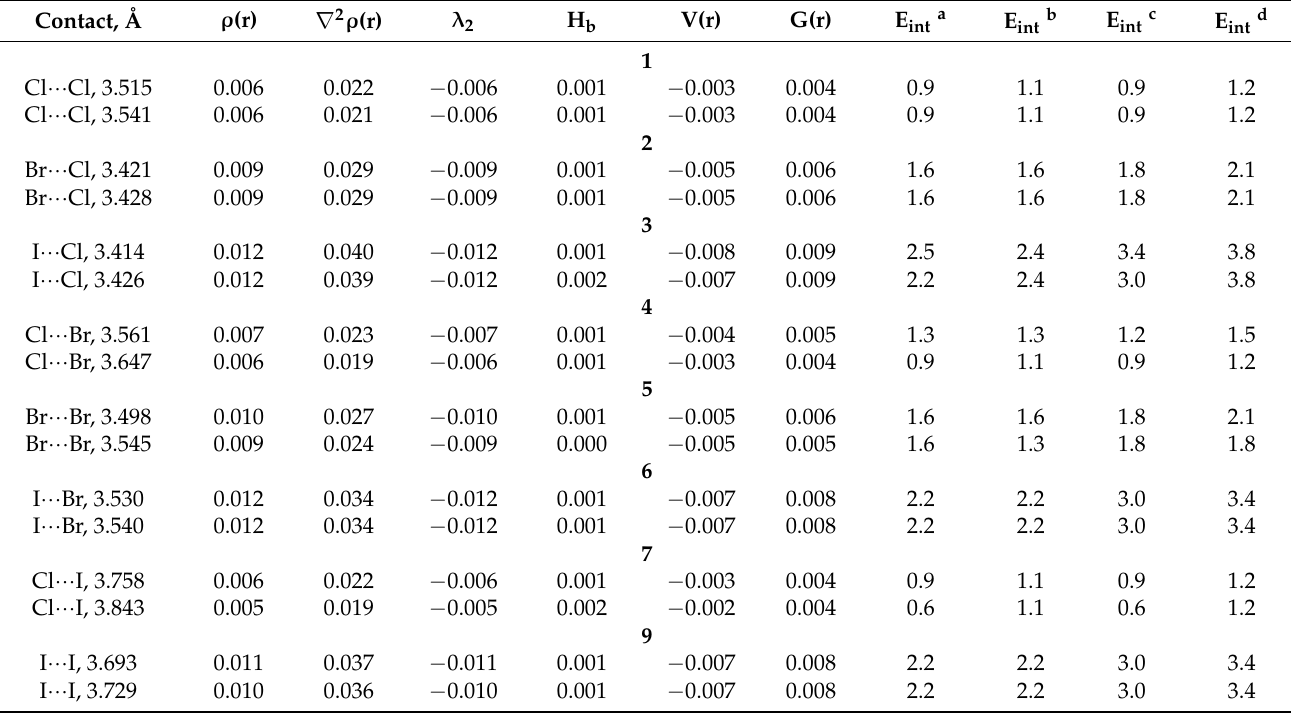
Table 3. Values of the density of all electrons— ρ ( r ), Laplacian of electron density— ∇ 2 ρ ( r ) and appropriate λ 2 eigenvalues, energy density—H b , potential energy density—V( r ), and Lagrangian kinetic energy—G( r ) (a.u.) at the bond critical points (3, − 1), corresponding to the non-covalent interactions X ··· Y (X, Y = Cl, Br, I) in 1 – 7 and 9 , as well as energies for